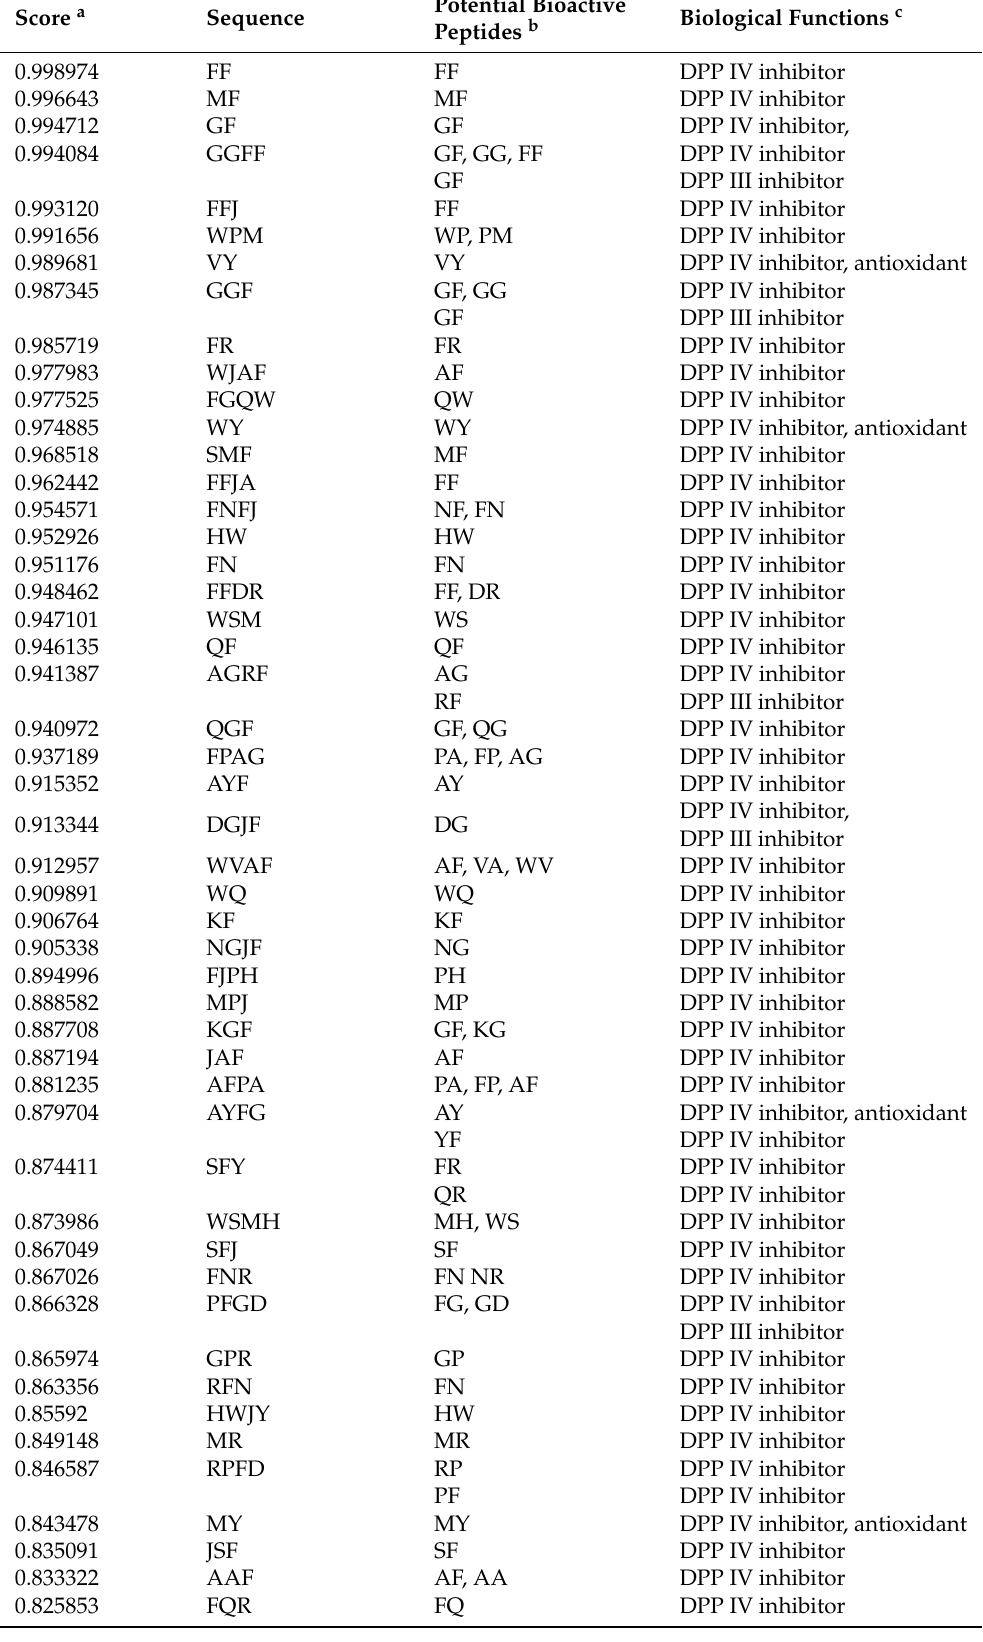
Table 4. Potential bioactivities according to PeptideRanker and BIOPEP database